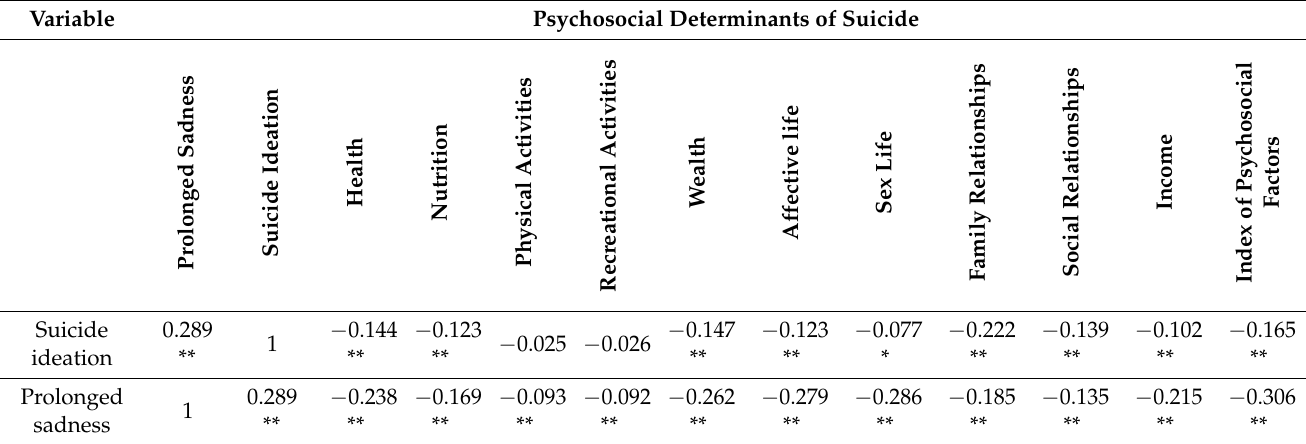
Table 1. Correlations between suicide ideation/prolonged sadness and psychosocial